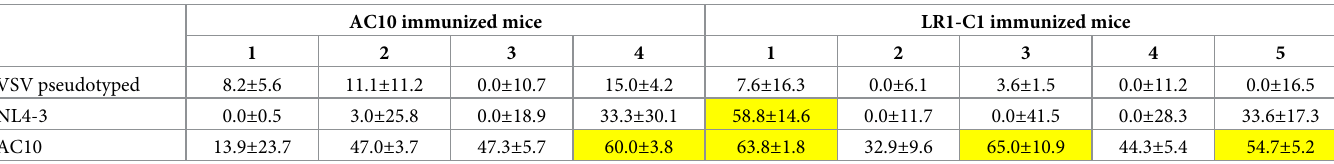
Table 3. Neutralization of AC10_29 and LR1-C1 immunized mice.